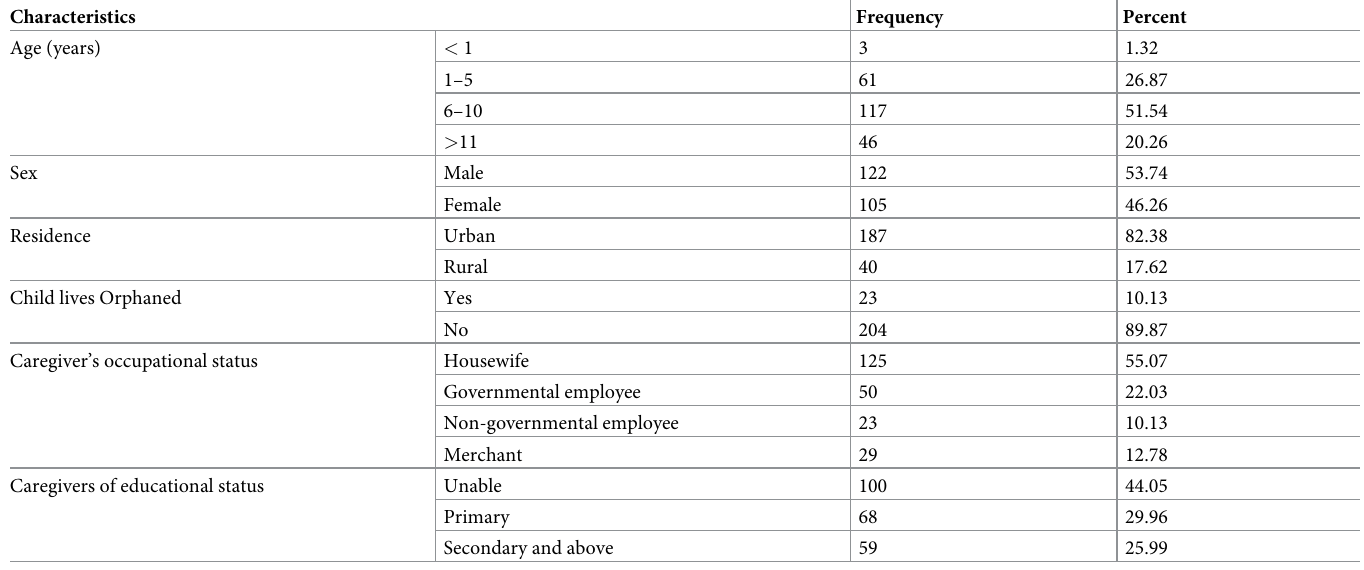
Table 1. Socio-demographic characteristics among TB and HIV co-infected children after test and treat strategies launched in northwest Ethiopia hospitals, 2021.